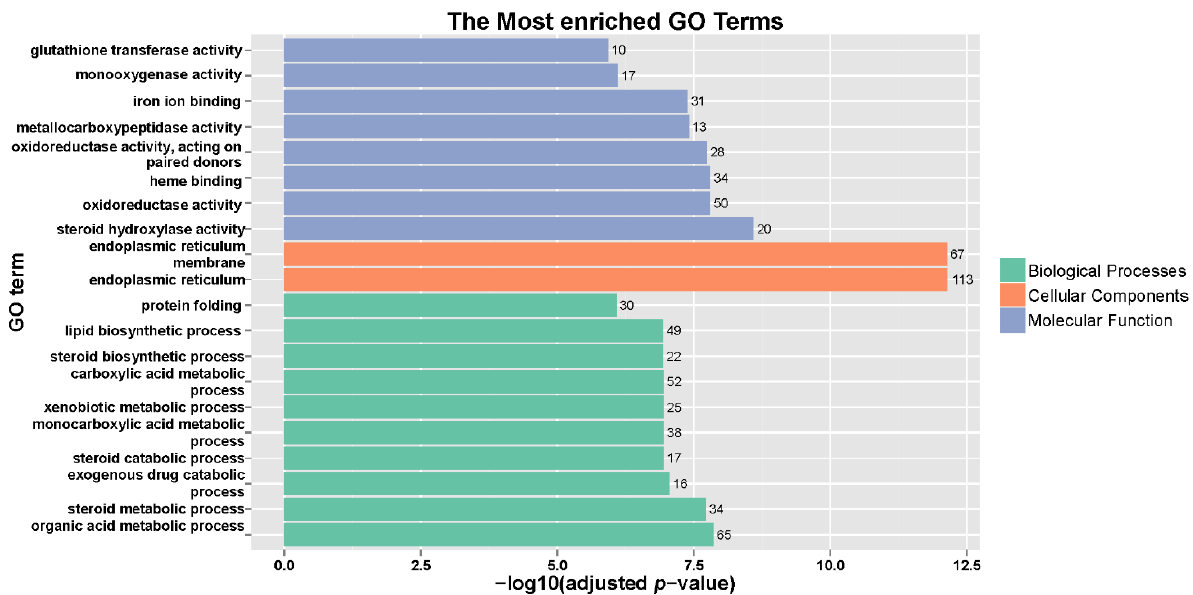
Figure 2. Gene ontology annotation of the differentially expressed genes in the three main GO categories: biological process, cellular component, and molecular function. The x-axis means adjusted p -value, the y-axis shows the top 20 most represented GO terms, and the values on the right of the columns represent the number of differentially expressed genes.